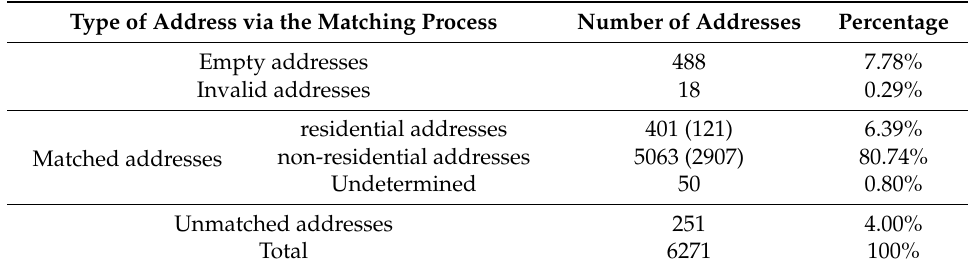
Table 1. The result of address string matching between physician and parcel